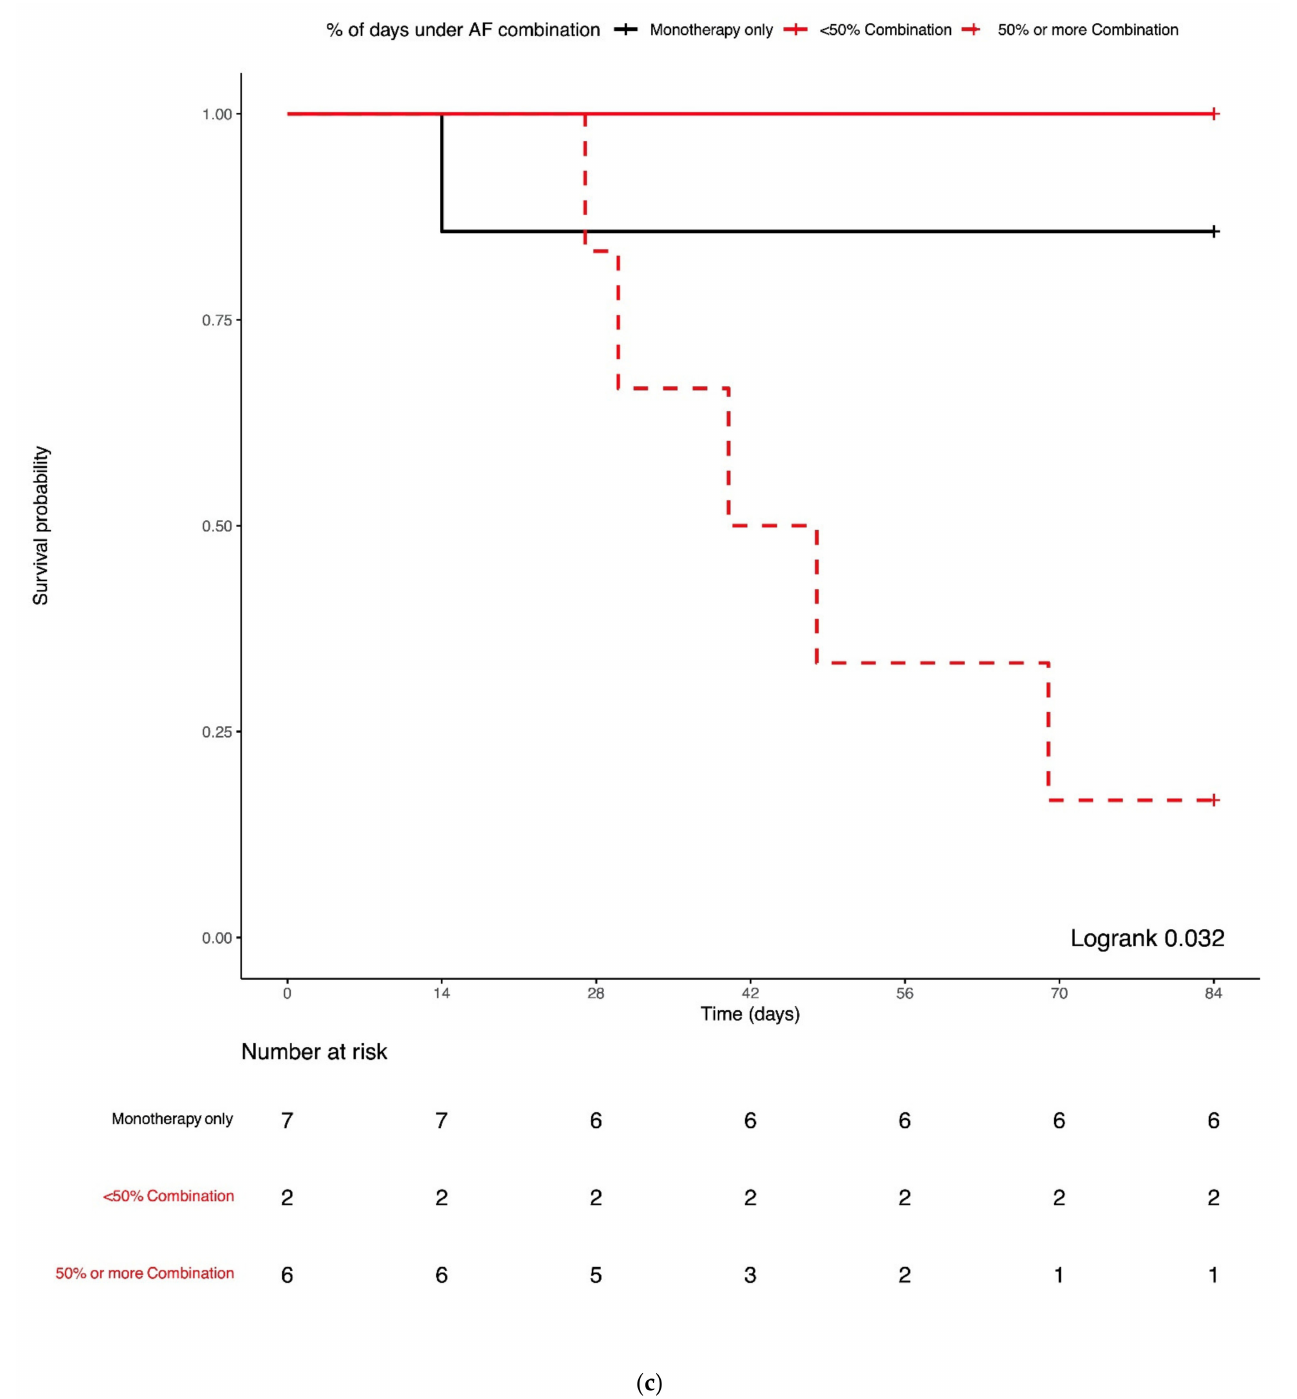
Figure 3. Kaplan–Meier survival curves of all-cause 12-week mortality after the diagnosis of an invasive mold infection (IMI) according to the number of days of combination therapy administration: Monotherapy only, and <50% and ≥ 50% of combination treatment of their entire treatment course for: ( a ) all patients with IMI, ( b ) patients with invasive aspergillosis (IA), and ( c ) patients with non-IA IMI. IMI: invasive mold infection, IA: invasive aspergillosis, non-IA: non-IA IMI, AF: antifungal